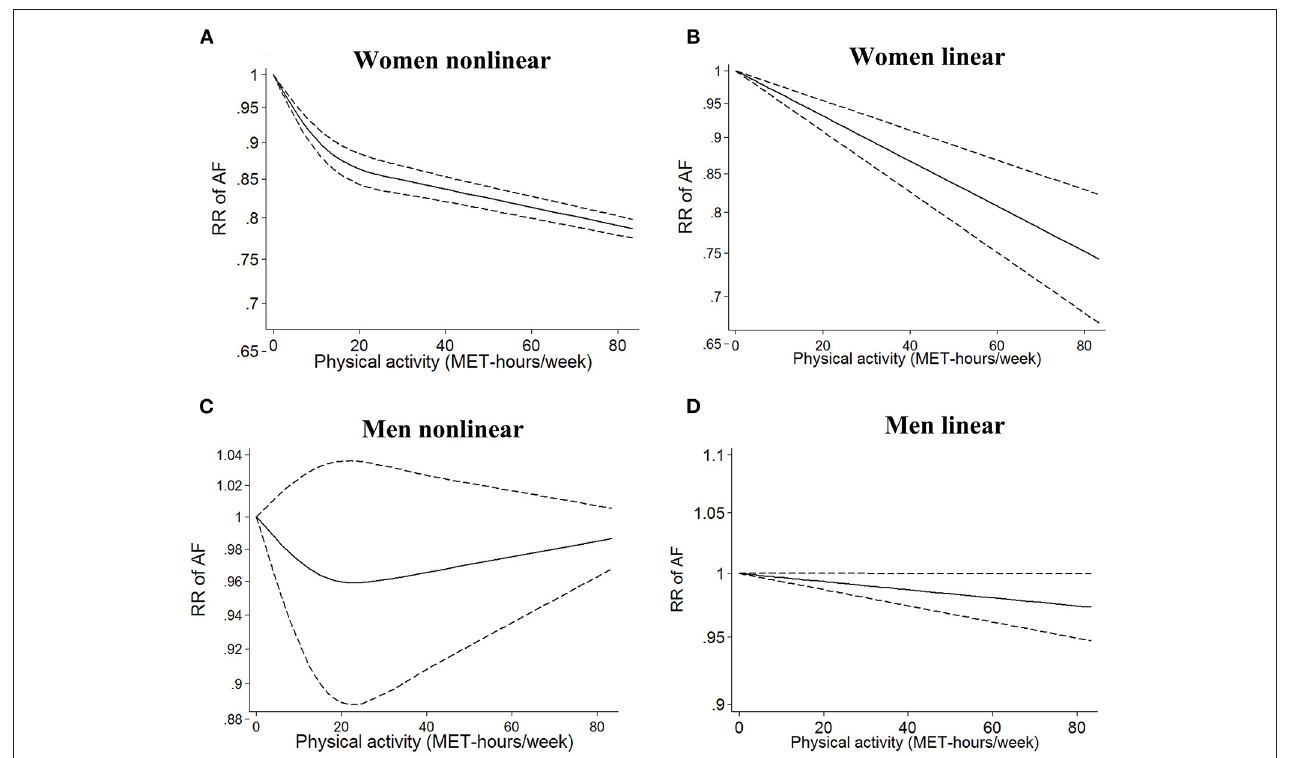
FIGURE 3 | Dose–response analysis of physical activity and atrial fibrillation in the sex-stratified analysis. ( A,B) Non-linear and linear models of PA and AF in females. (C,D) Non-linear and linear models of PA and AF in males. The bold and dashed lines represent the estimated RR and 95% CI, respectively. The non-linear models were fit by using a restricted cubic spline. PA, physical activity; AF, atrial fibrillation; RR, risk ratio; CI, confidence